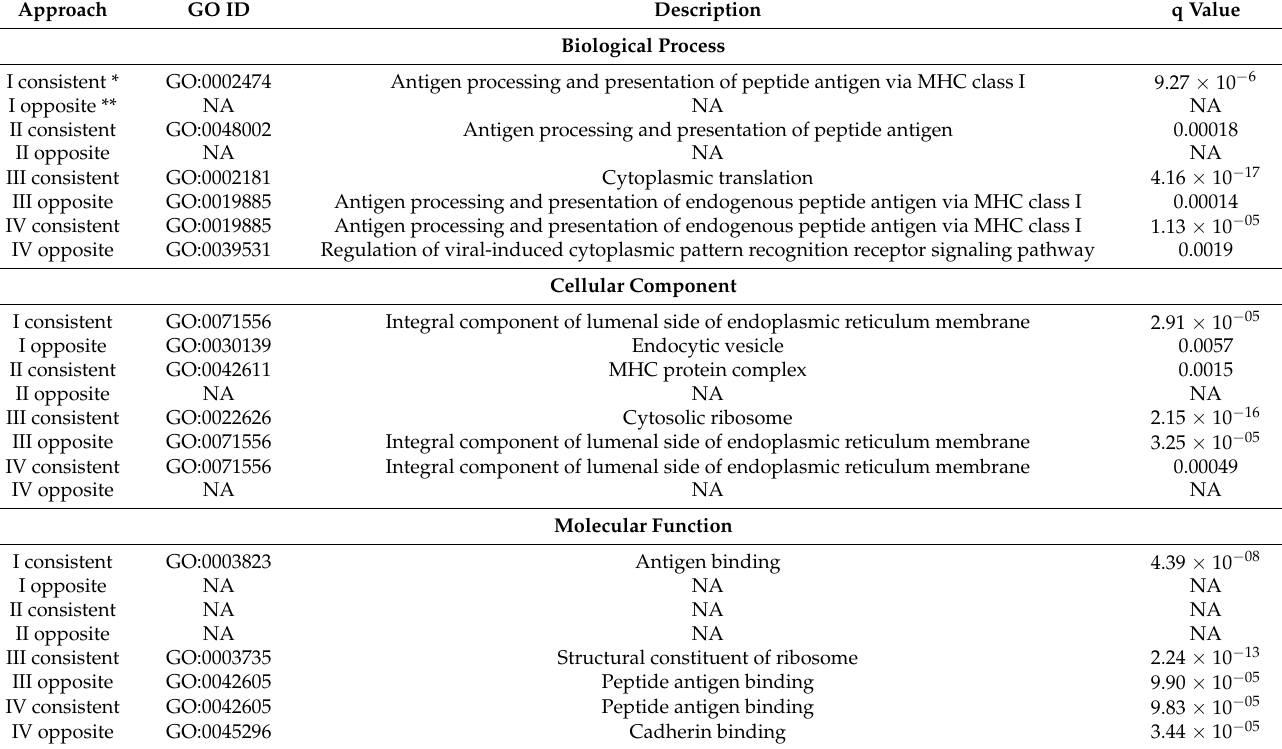
Table 1. Gene ontology most significantly enriched terms.